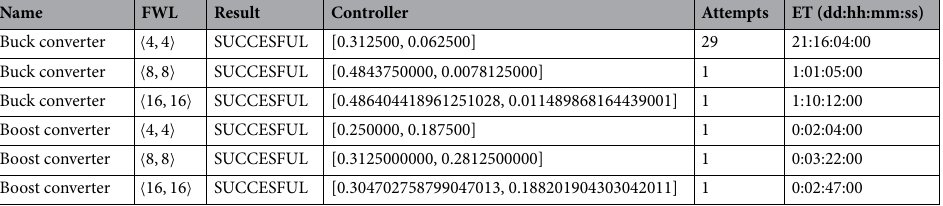
Table 5. Experiments for both settling time and overshoot. It contains information about the converter name, FWL format, synthesis result, the synthesized controller, number of attempts to synthesize the controller, and total synthesis